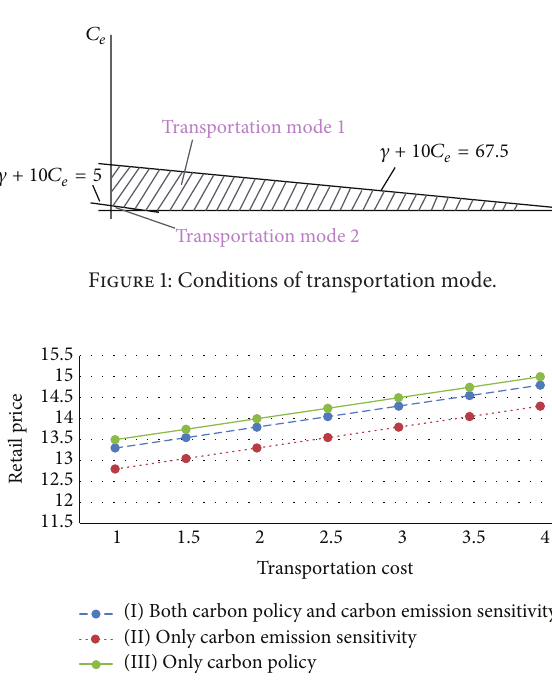
Figure 2: Effect of transportation cost on retail